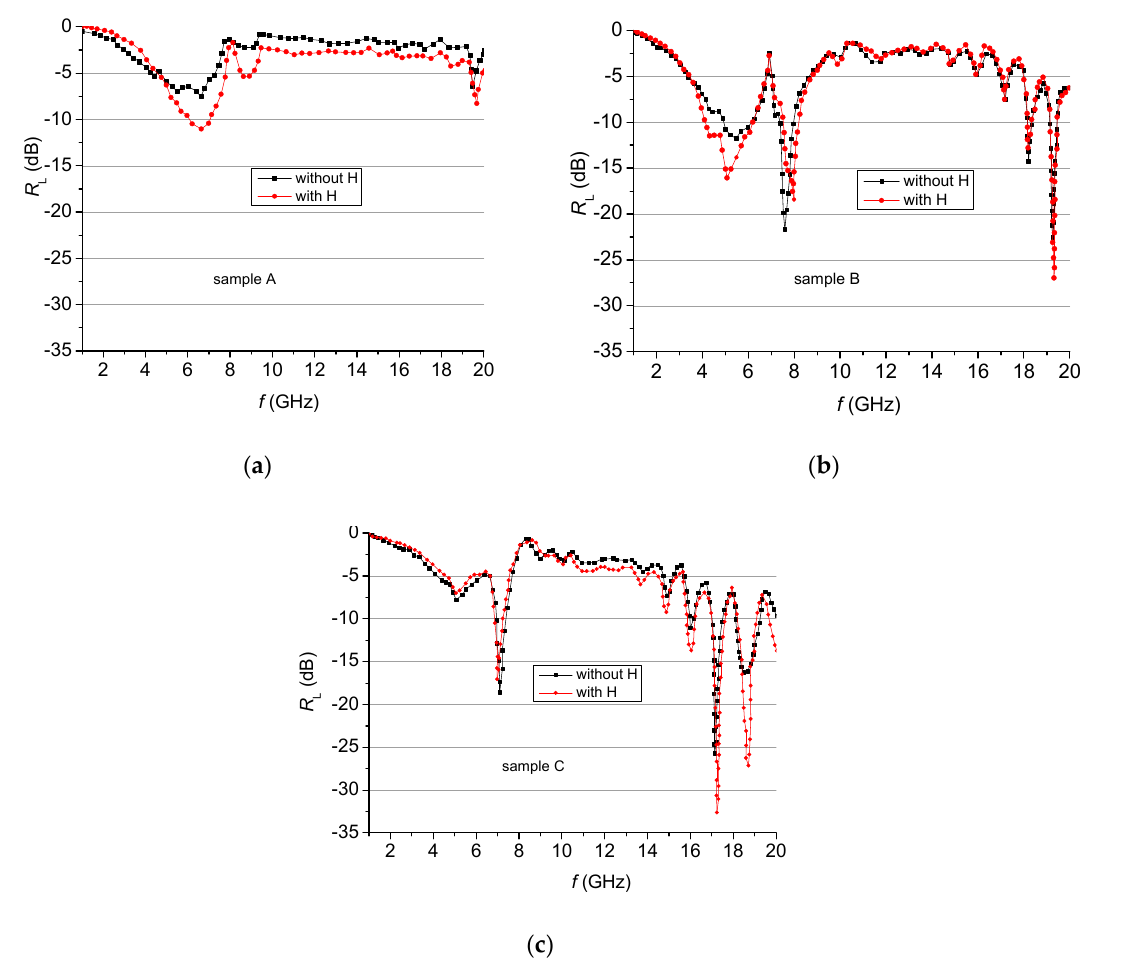
Figure 13. Reflection losses for samples ( a ), ( b ) and ( c ) with and without an external magnetic field.